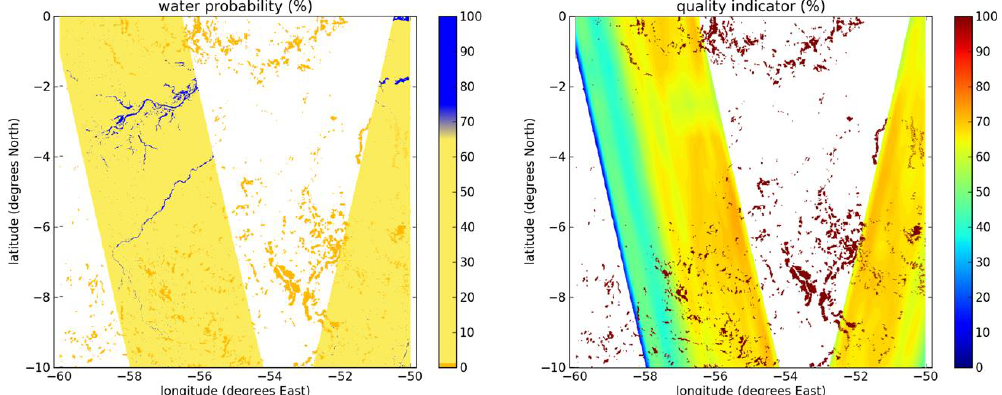
Fig. 6. Output of a single day 10 × 10 latitude–longitude tile of water probability (left panel) and the corresponding quality indicator q . Figure 6. Output of a single day 10x10 lat-lon tile of water probability (left) and the 3 Places where the HAND index are higher than 15 are set to q =100, water probability=0 in a pre-processing corresponding quality indicator q . Places where the HAND index are higher than 15 are set to 4 q =100, water probability=0 in a pre-processing phase. 5